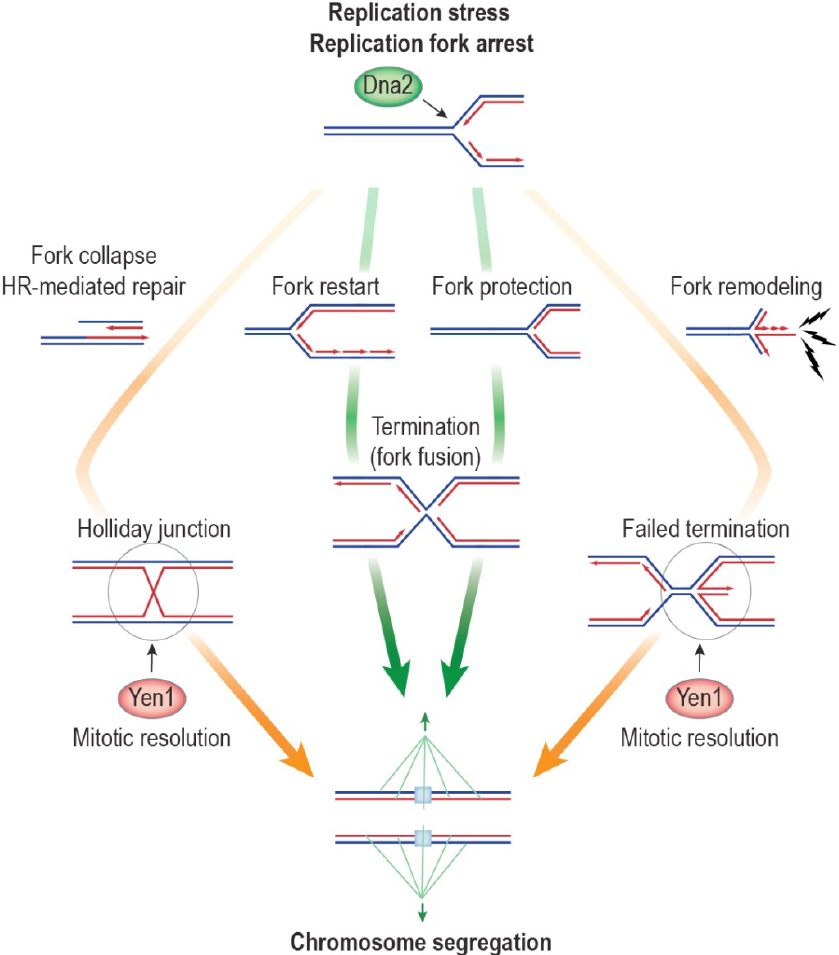
Dna2 helicase-defective cells, and a pos- tion. These pathways (orange arrows) are resolved by Yen1 in anaphase, ensur- ing viable chromosome